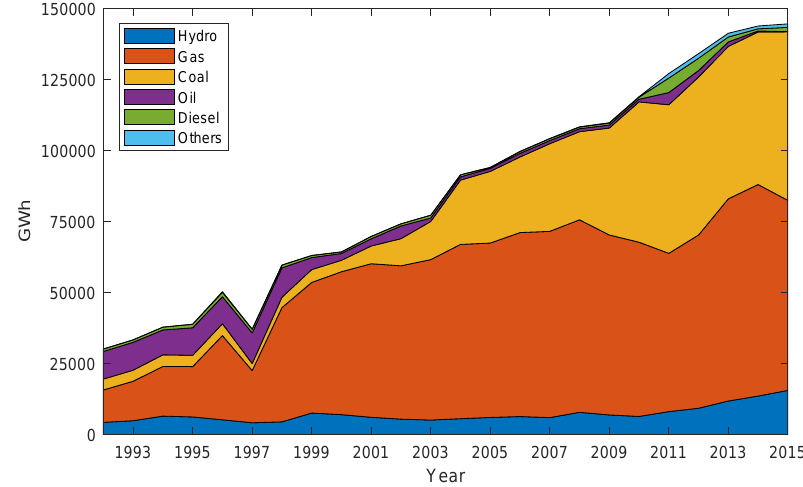
Figure 1. Electricity generation mix in GWh